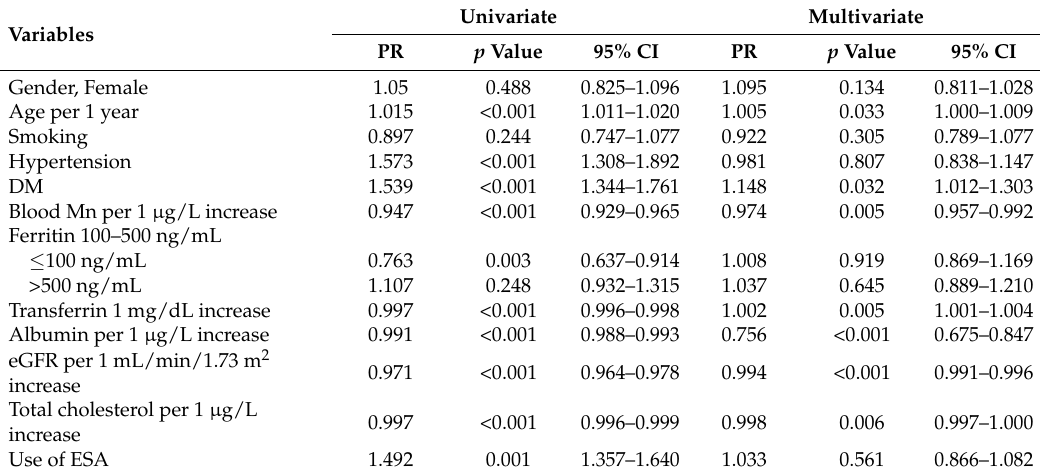
Table 3. Poisson regression analysis with robust variance between anemia and blood Mn, clinical and nutritional factors.